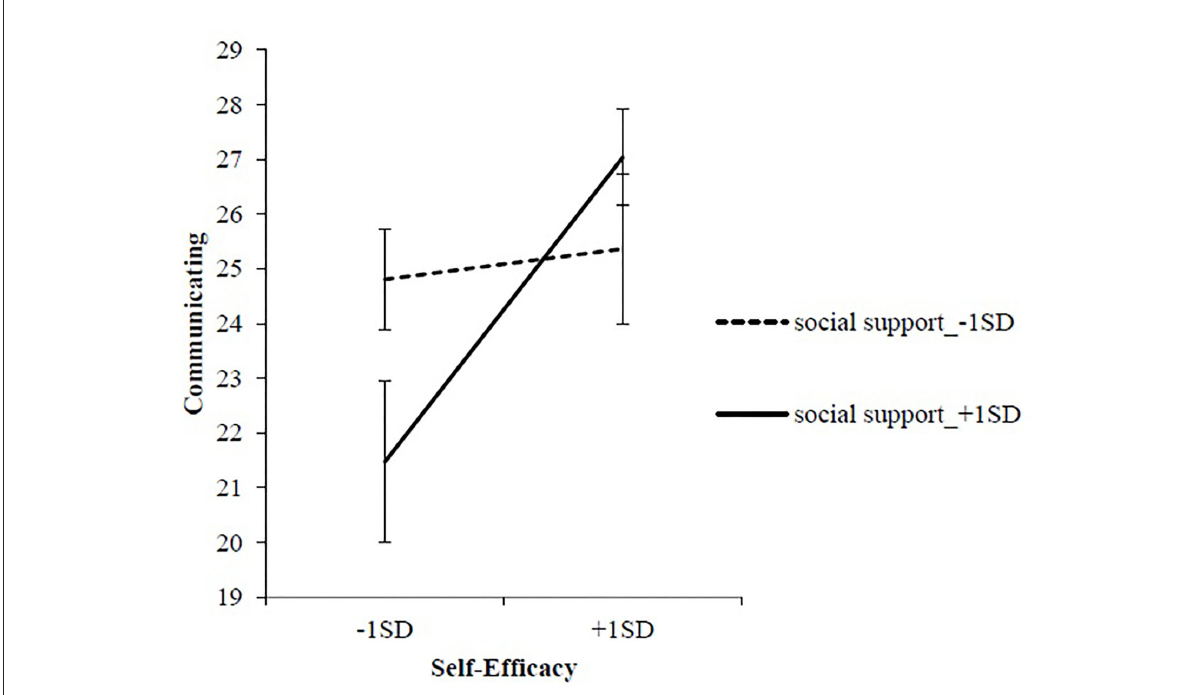
FIGURE3 The interaction between self-efficacy and social support related to communicating in the action/maintenance